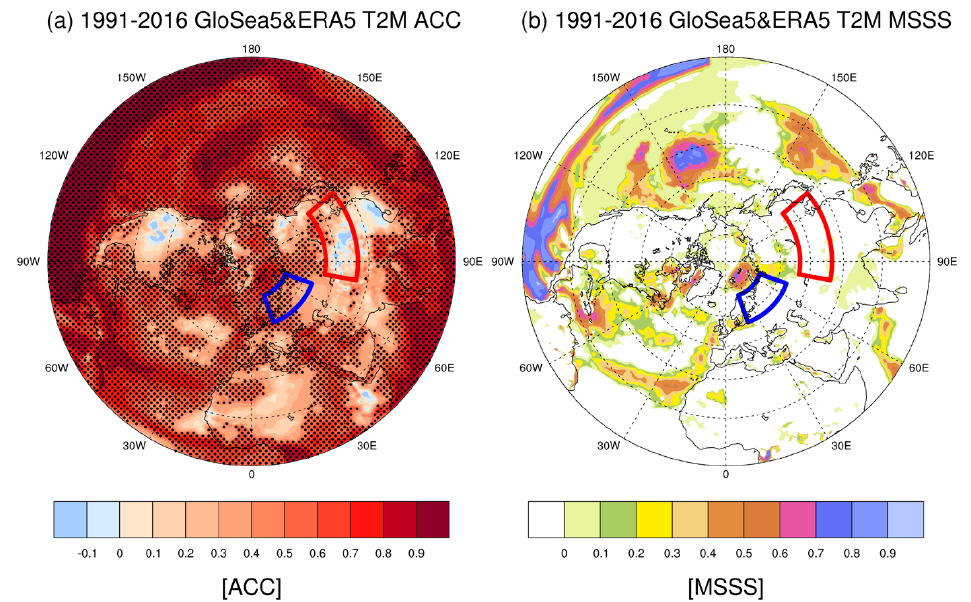
Figure 1. GloSea5 hindcast experiments were evaluated against ERA5 data. ( a ) Anomaly correlation coefficient (ACC) and ( b ) mean-squared skill score (MSSS) from December to February (DJF mean) of 1991–2016 for surface temperature (T2m). Blue and red boxes indicate the areas of Northern Europe and East Asia, respectively. The black dots indicate statistical significance at the 95% confidence level.